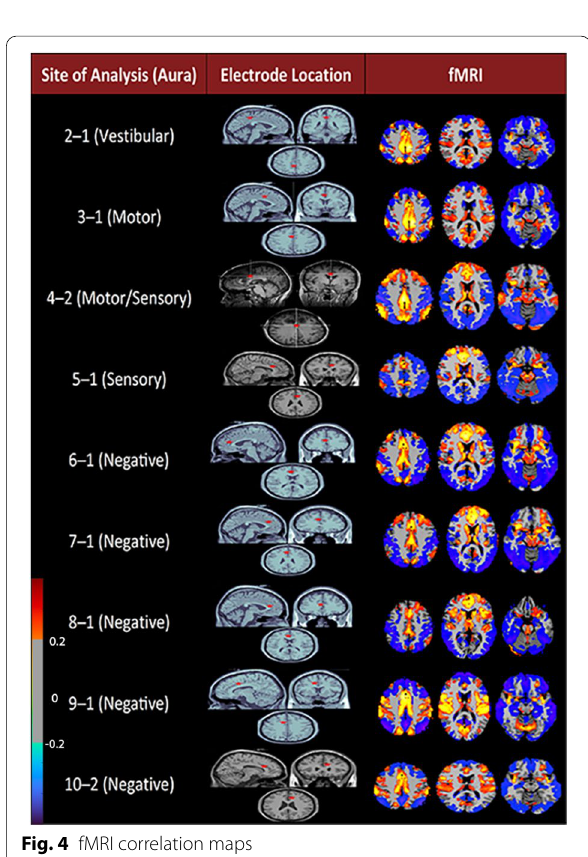
Fig. 4 fMRI correlation